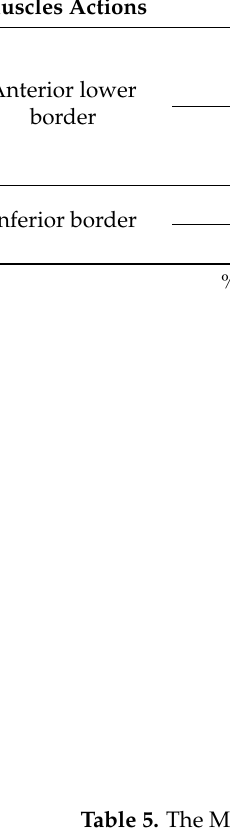
Table 5. The MaxVMS of screws in three fixation groups with mandibular symphysis fracture (Unit: MPa). Muscles